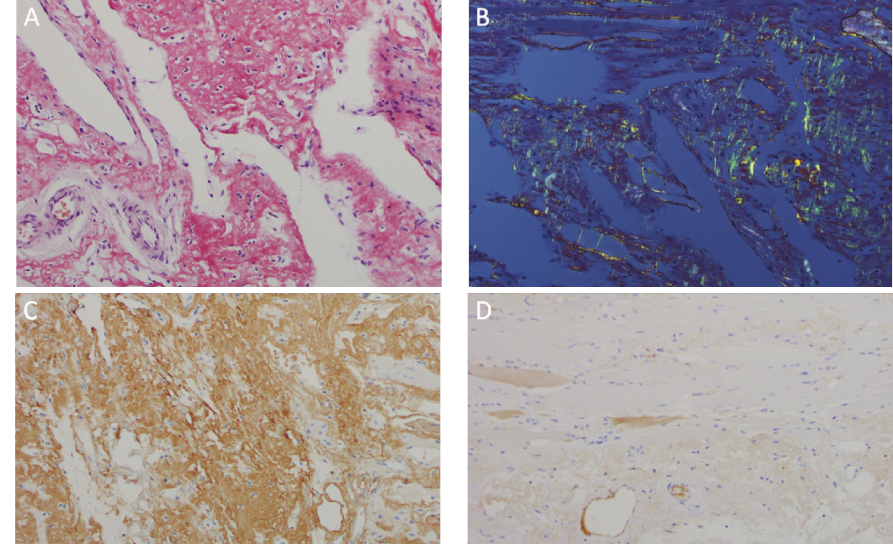
Figure 2: Diaphragmatic amyloidosis. (A) Congo red stain of diaphragm showing diffuse positive staining (red-orange) of amorphous extracellular material, 200x. (B) Congo red stain of diaphragm showing apple-green birefringence under polarized light, 200x. (C) Kappa light chain immunostain of diaphragm showing diffuse positivity, diagnostic of kappa amyloid light chain amyloidosis, 20x. (D) Negative lambda light chain immunostain of diaphragm, 20x.